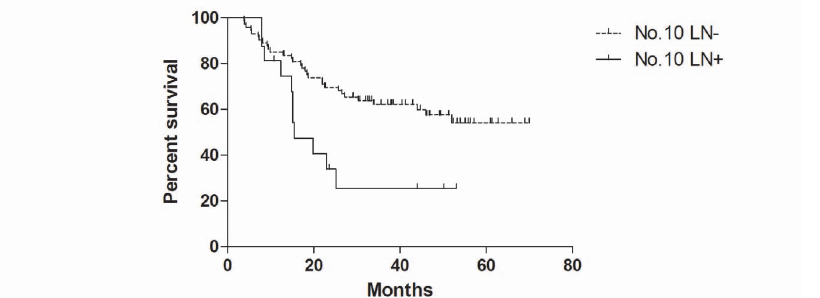
Figure 6. Kaplan-Meier survival analysis of No.10 LNs for R0 group in patients with histological evidence of LNs structure in No.10 LNs.